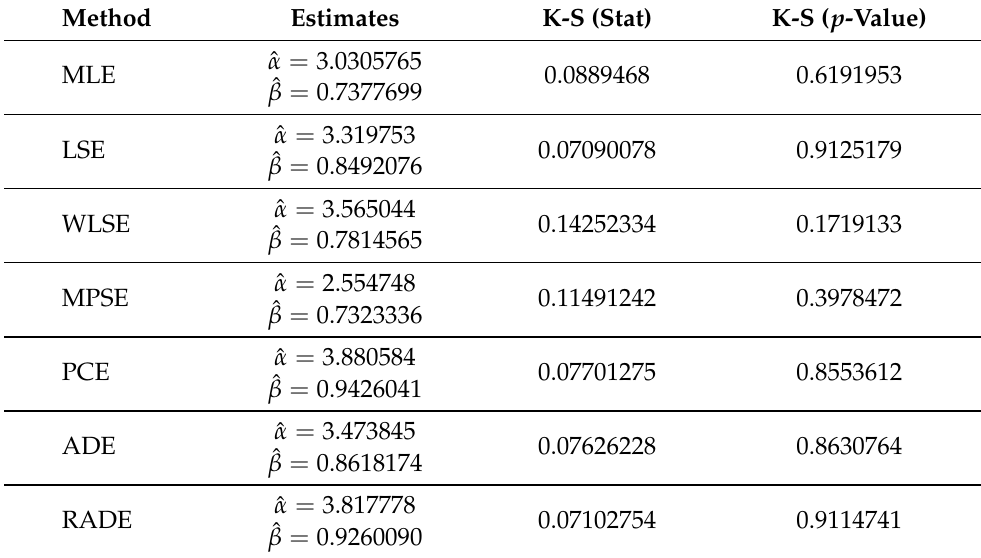
Table 9. Estimates of the omega parameters and Kolmogorov–Smirnov (K-S) (stat) with its associated p -value from seven methods of